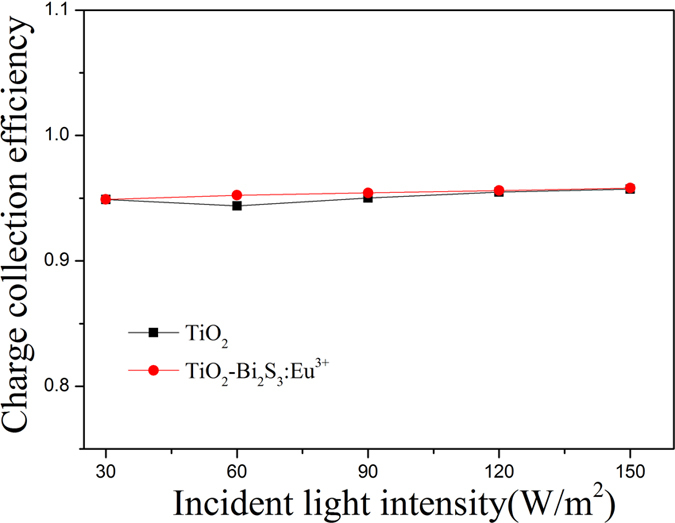
Comparison of charge collection efficiency for DSSCs comprised of pure TiO2 cell and TiO2-Bi2S3:Eu3+ cell.